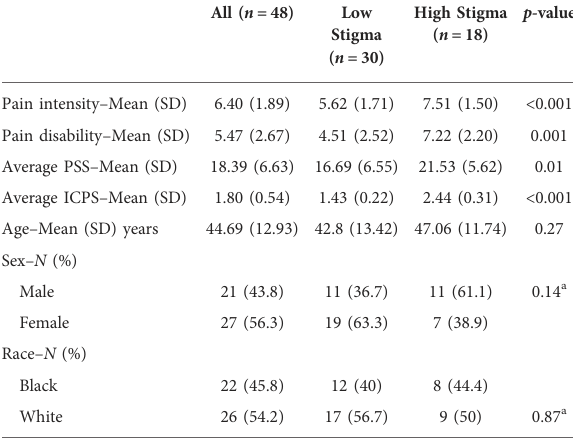
TABLE 1 Demographic variables considered in analyses.